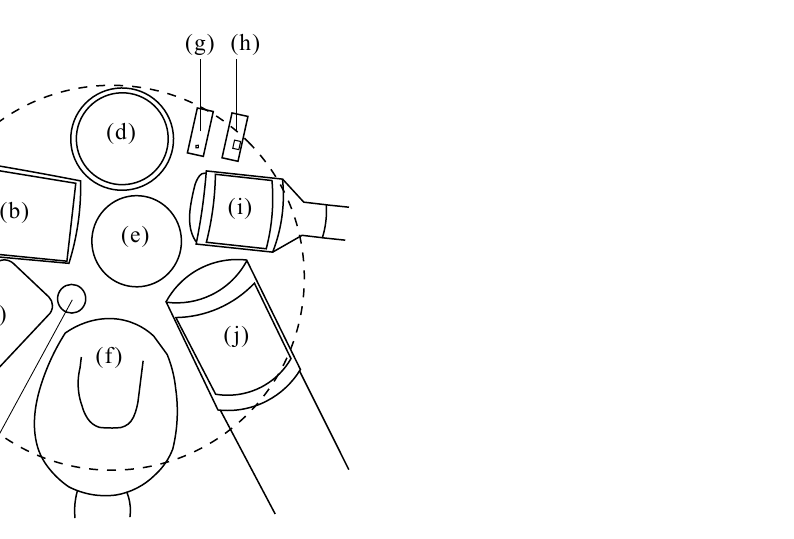
Figure 1. Recording microphone array. (a) AKG C12; (b) AKG C414 B-XLS; (c) DPA 4006-TL; (d) Elec- trovoice RE20; (e) Shure SM58; (f) Coles 4038; (g) Wolfson WM7131; (h) Knowles SPU0410HR5H; (i) AKG C451; (j) sE 2200a. Dashed line represents 150 mm diameter circle within which all micro- phone capsules